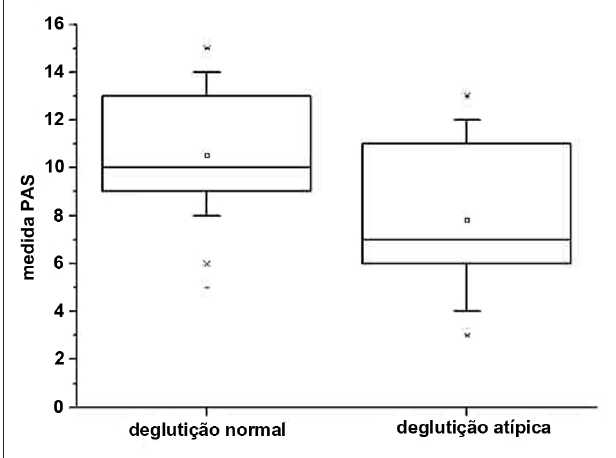
Figura 2. Conjunto de dados da medida PAS nos grupos de deglu- tição normal e atípica. A linha interna da caixa marca a mediana do conjunto